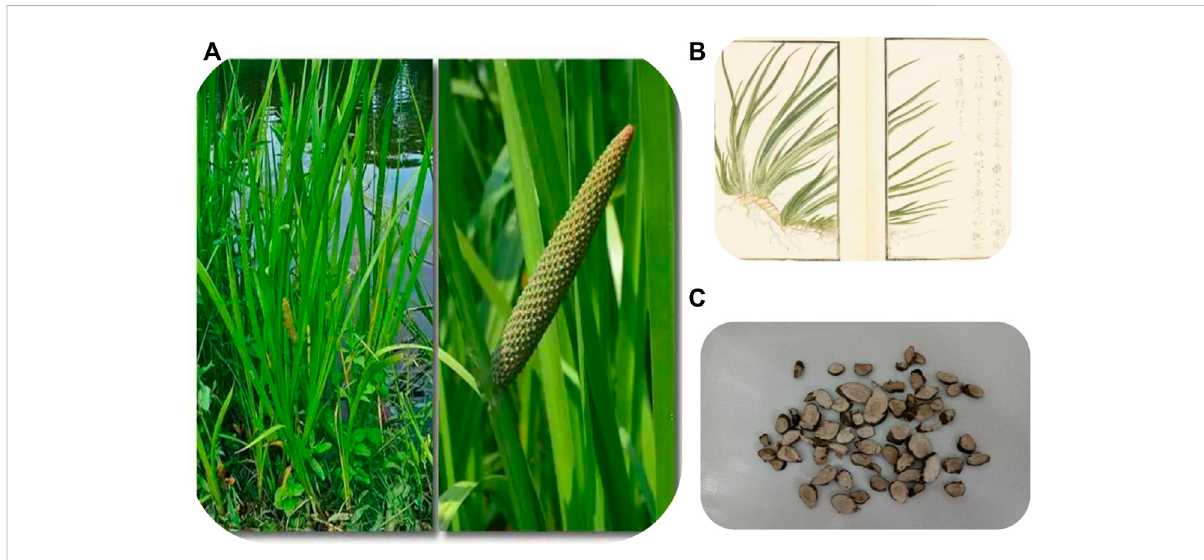
FIGURE 1 Plant morphology (A) (B) and section morphology (C) of ATT. (A) Is from Sohu.com, which shows the whole plant of ATT; (B) from Atlas of Materia Medica, also showing the whole plant of ATT; (C) is a slice of